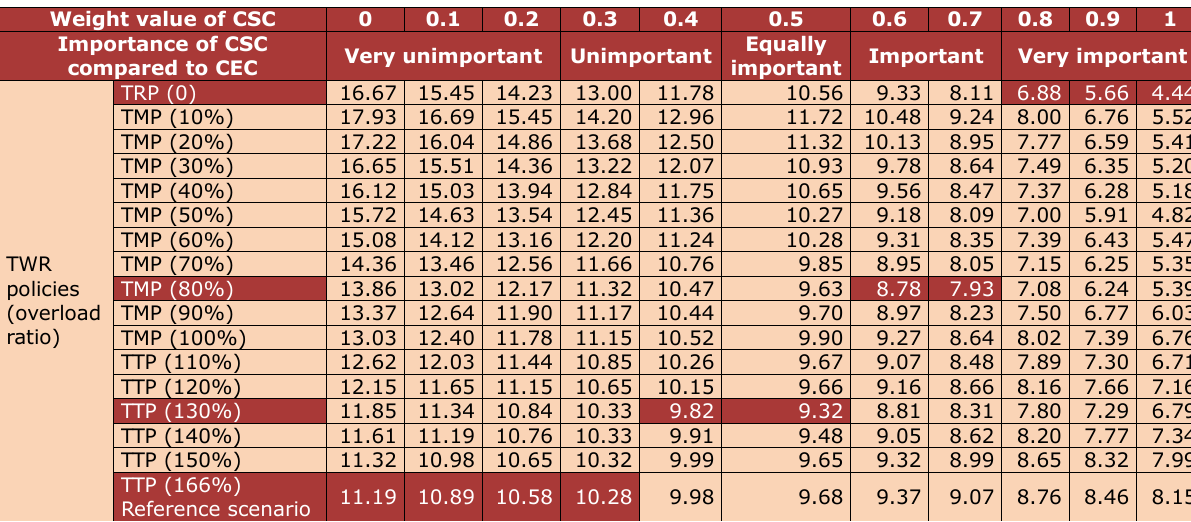
Table 3. The best policies under the varying relative importance of CSC (Units: billion